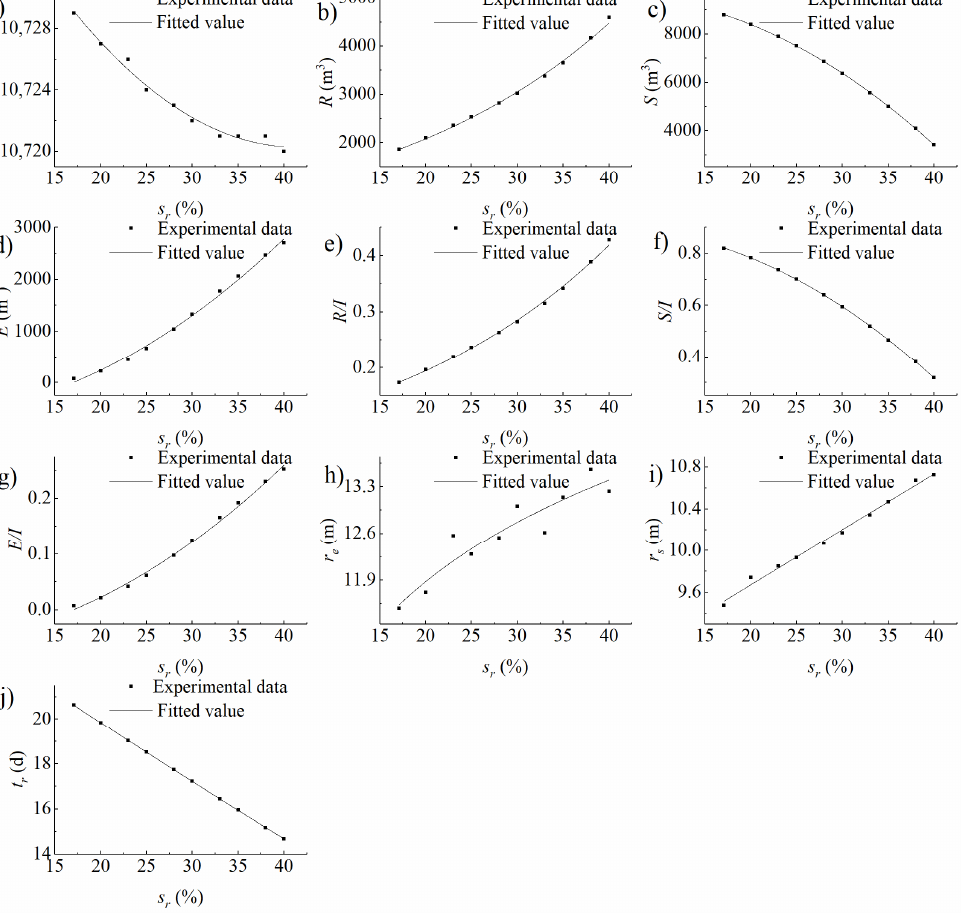
Figure 5. The variations with an increment in s r. (( a ) variation of I; ( b ) variation of R; ( c ) variation of S; ( d ) variation of E; ( e ) variation of R/I; ( f ) variation of S/I; ( g ) variation of E/I; ( h ) variation of r e ; ( i ) variation of r s ; ( j ) variation of t r .).